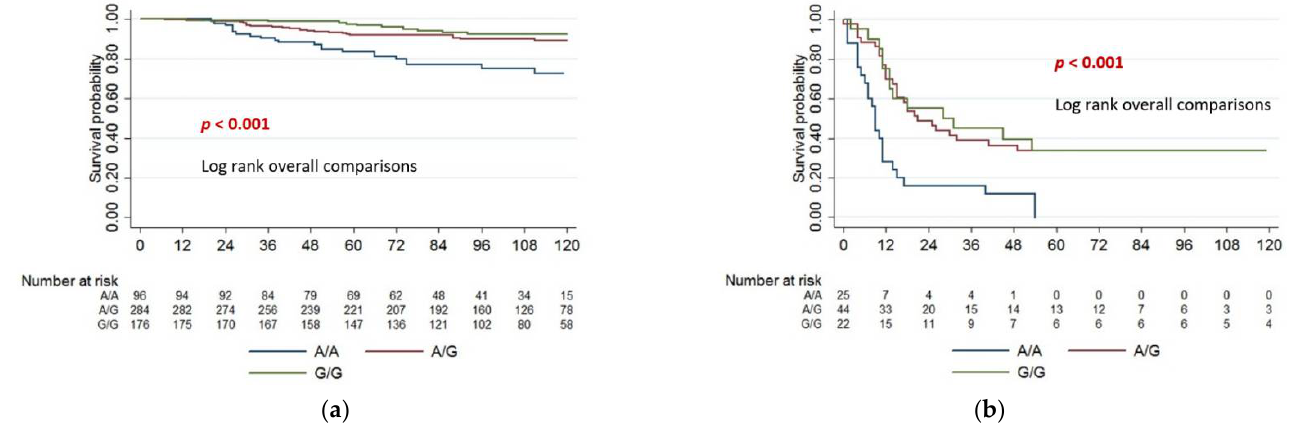
Figure 2. Kaplan–Meier curves stratified for the three different genotypes at rs7551288, patients homozygous for the rs7551288*A allele (A/A), heterozygous (A/G) and homozygous for the rs7551288*G allele (G/G). Survival probabilities were calculated from ( a ) date of primary diagnoses and ( b ) date of stage IV diagnoses until last date of follow up, time is given in months.